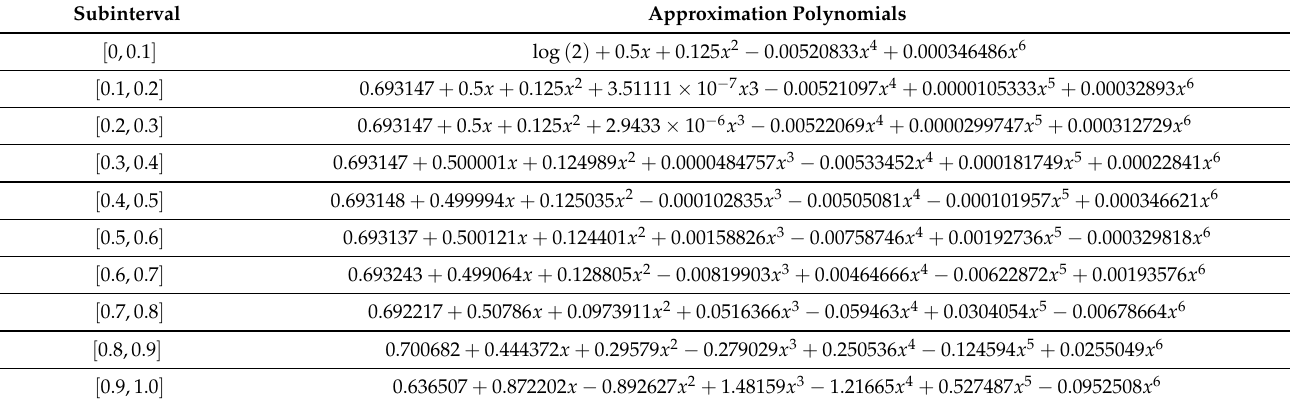
Table 5. Approximation spline for the problem (31).